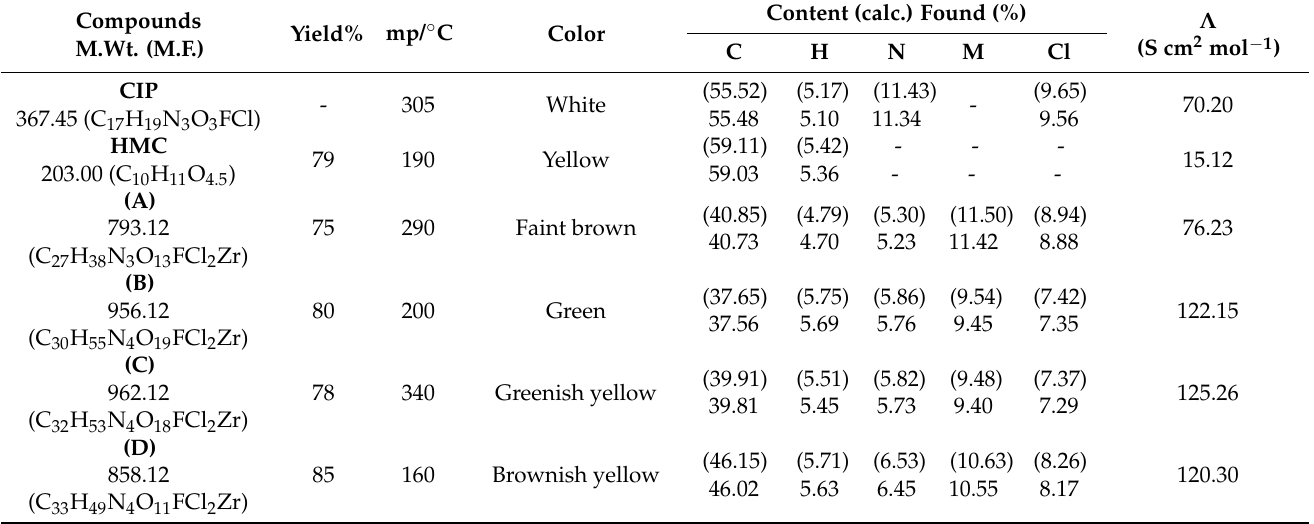
Table 1. Elemental analysis and physico-analytical data for CIP, HMC, and their Zr(IV) complexes